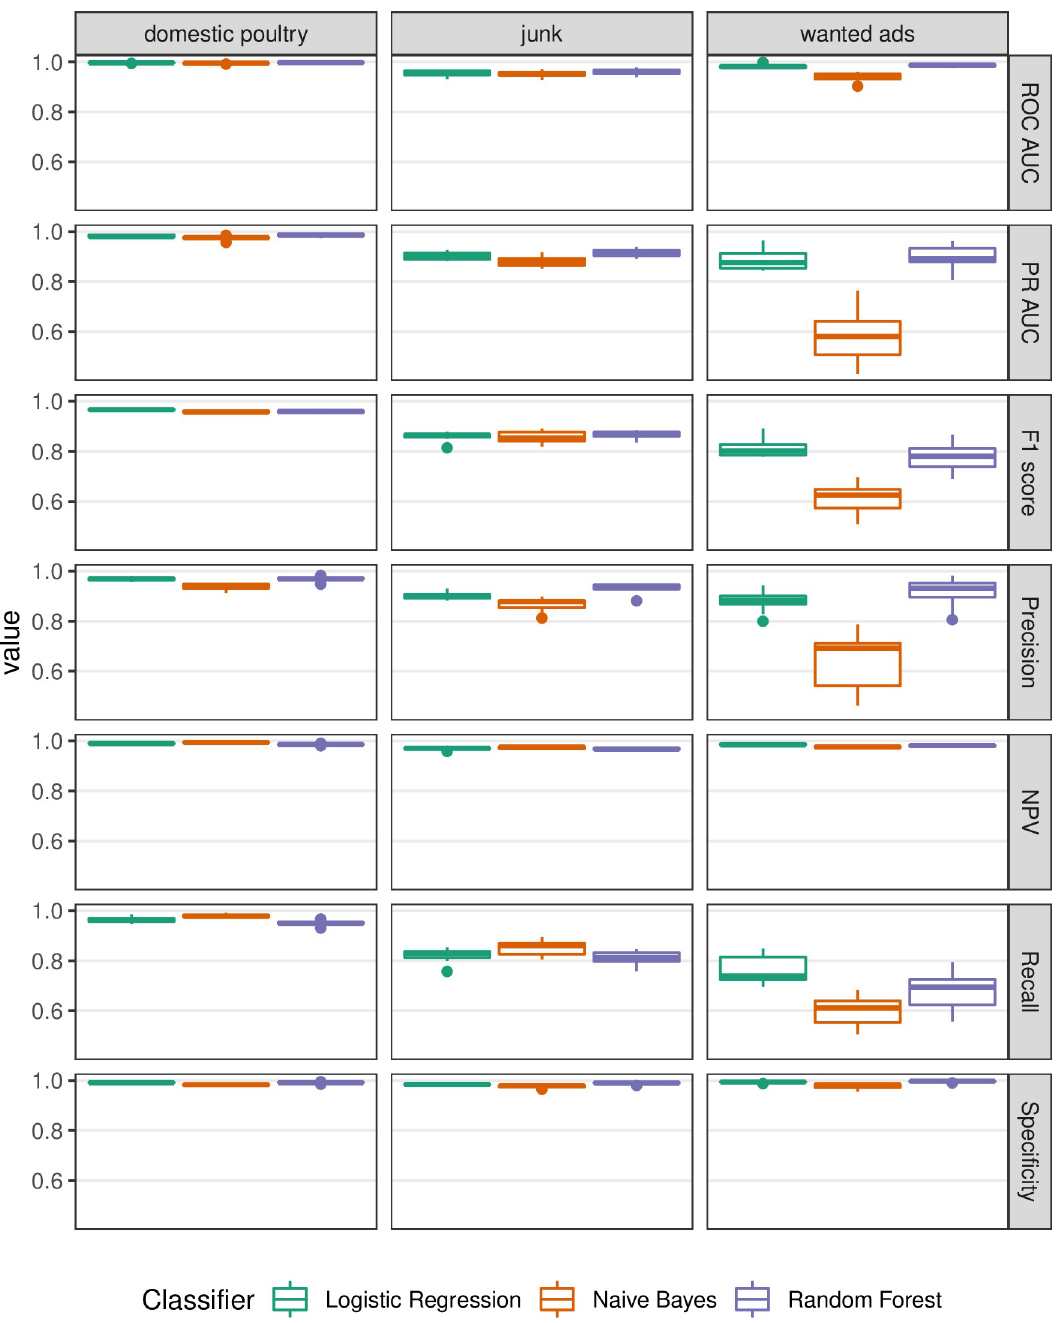
Fig 1. Model evaluation metrics for text classifiers. Evaluation metrics (rows) are derived from 10 cross-validation folds using different text classifiers evaluated for three different labels (columns). See S1 Appendix for more information and calculation of the evaluation metrics and S2 Appendix for exact metric